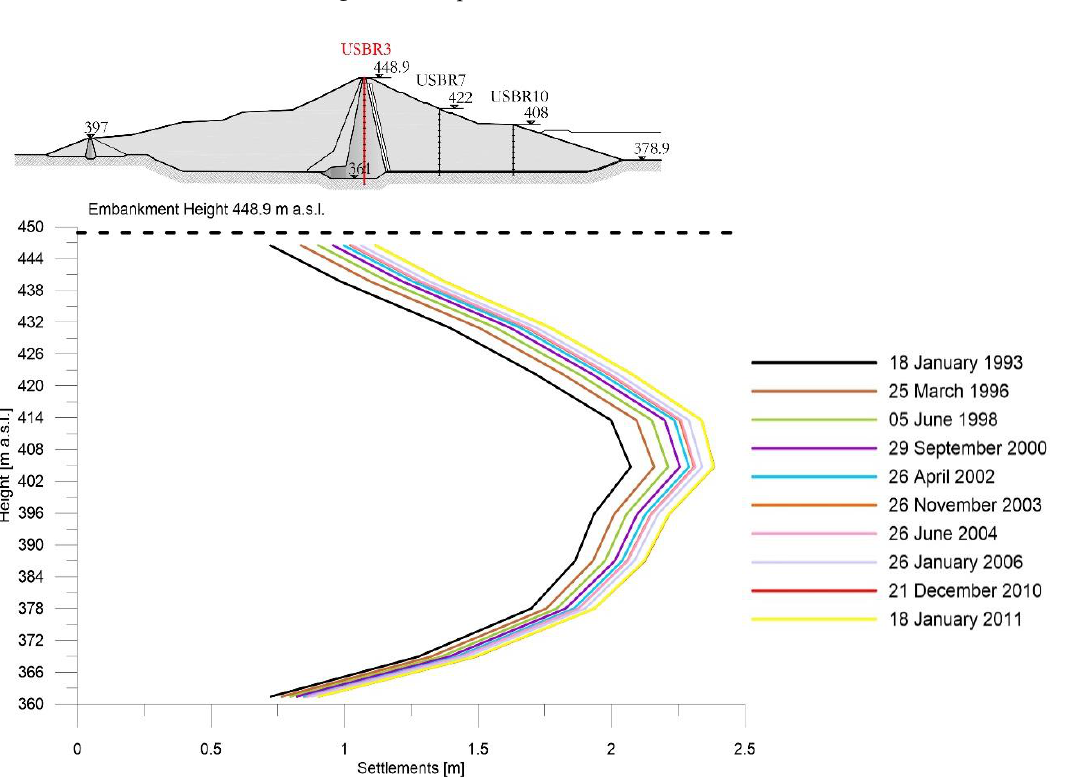
Figure 8. The piezometer measurements.